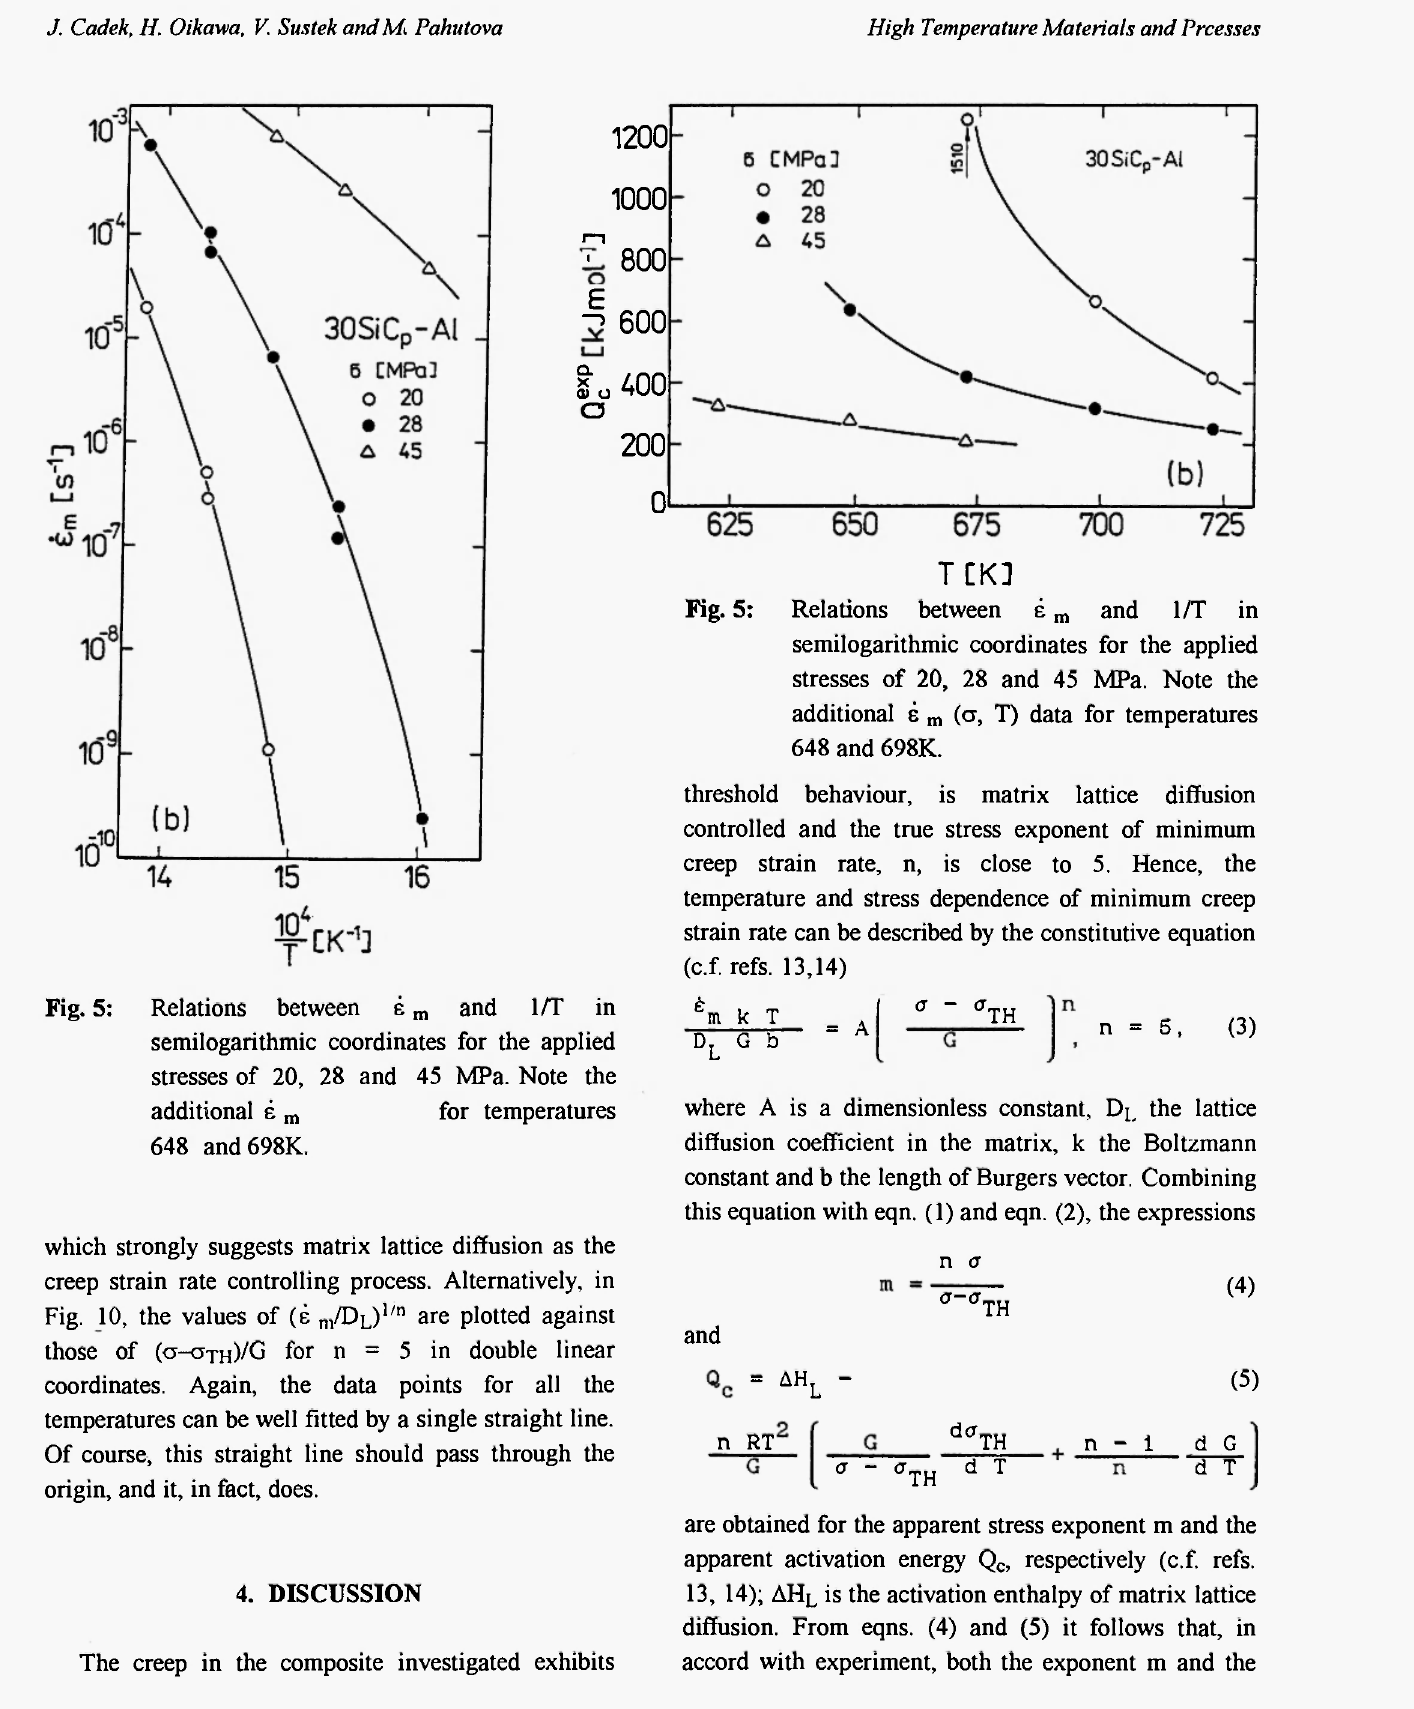
which strongly suggests matrix lattice diffusion as the creep strain rate controlling process. Alternatively, in Fig. 10, the values of (έ m /D L ) !/n are plotted against those of (a-ajnVG for η = 5 in double linear coordinates. the temperatures can be well fitted by a single straight line.